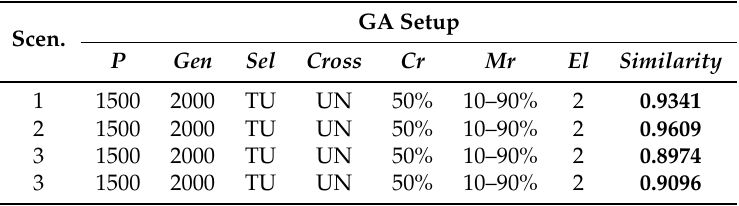
Table 2. Table that summarizes the results obtained by the best individual obtained after the application of the GA in the different